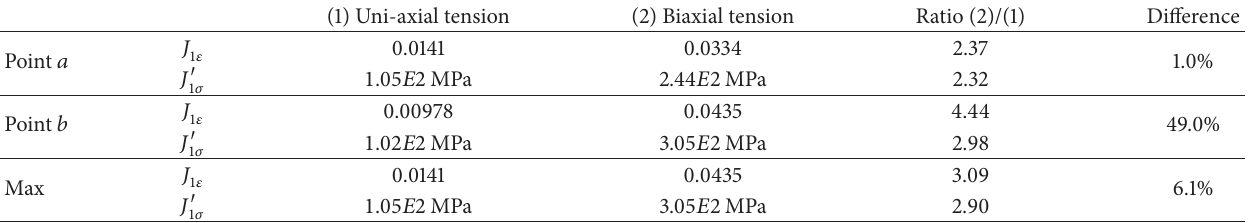
Table 6: Predicted 𝐽 1𝜀 and 𝐽 󸀠 1𝜎 values at critical points under uni-axial and biaxial tension loadings—orientation 2.